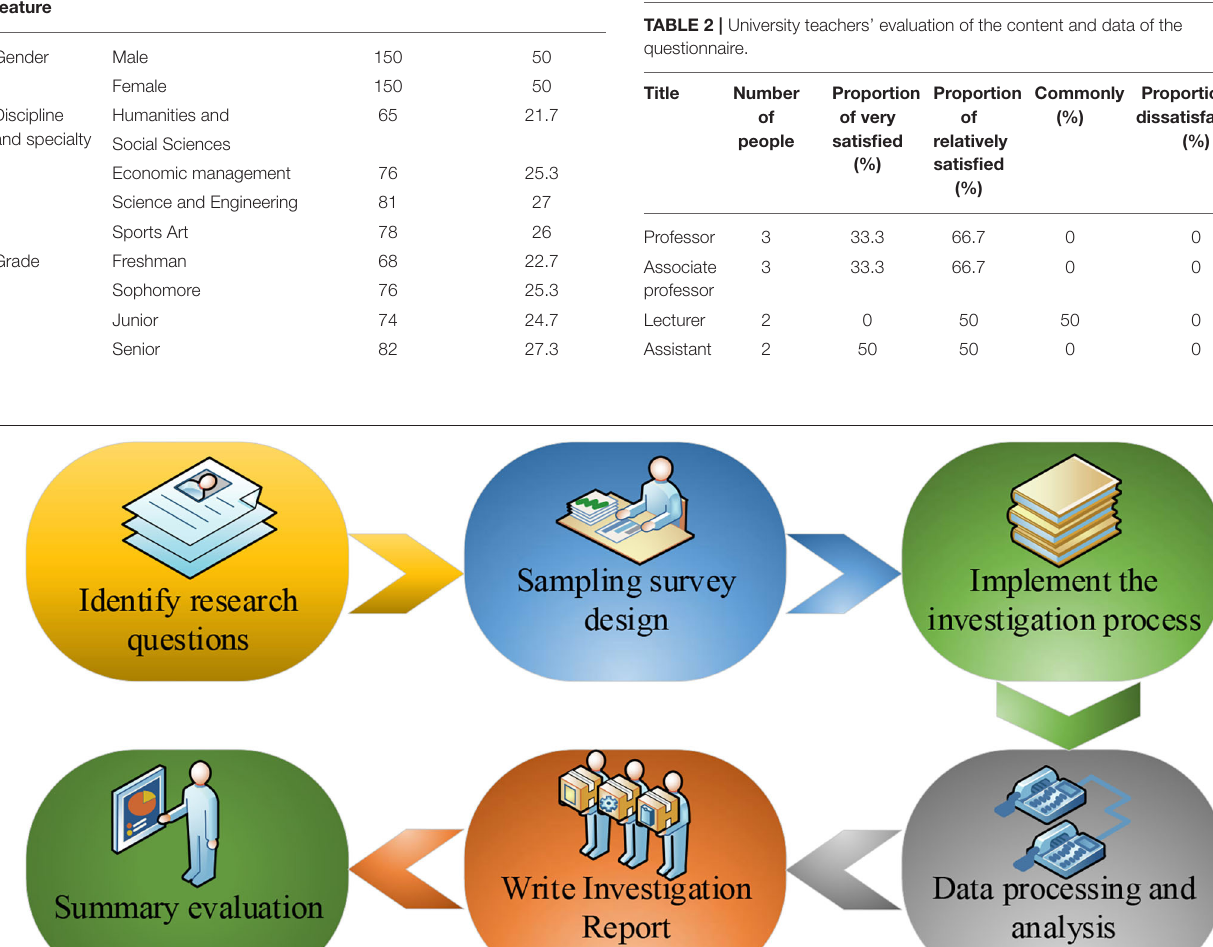
TABLE 1 | The basic characteristics of the interviewed college students. Basic feature